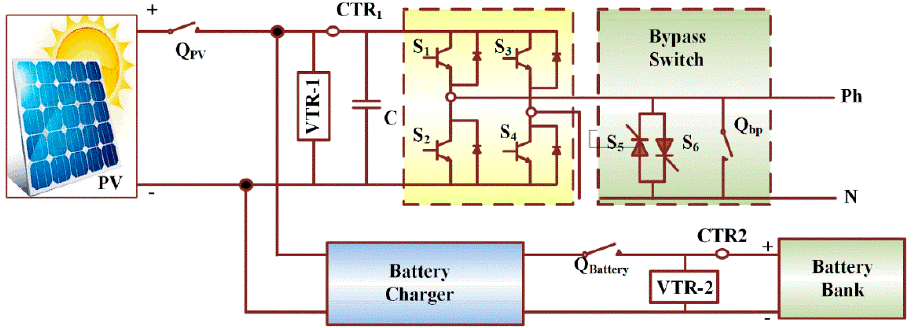
Figure 4. The basic building block of a CHB-based PCS .